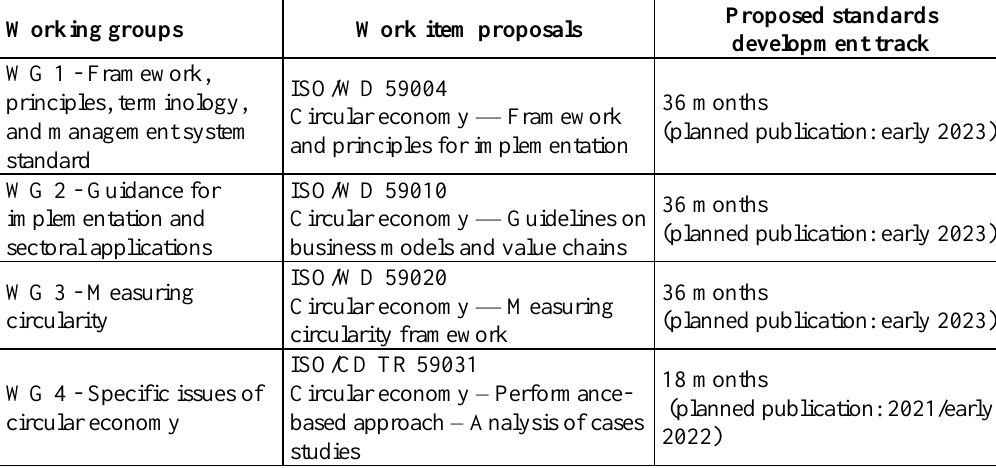
Table 1: ISO/TC 323 Working Groups, Work Item Proposals and Proposed Standards Development